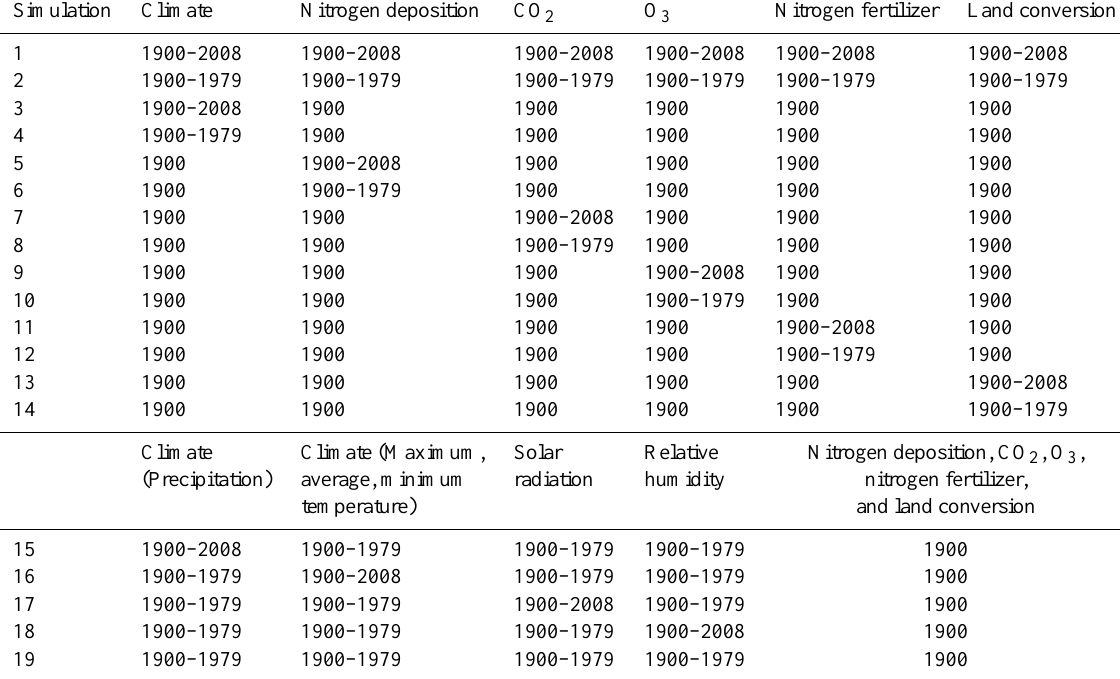
Table 1. Experimental design for this study.